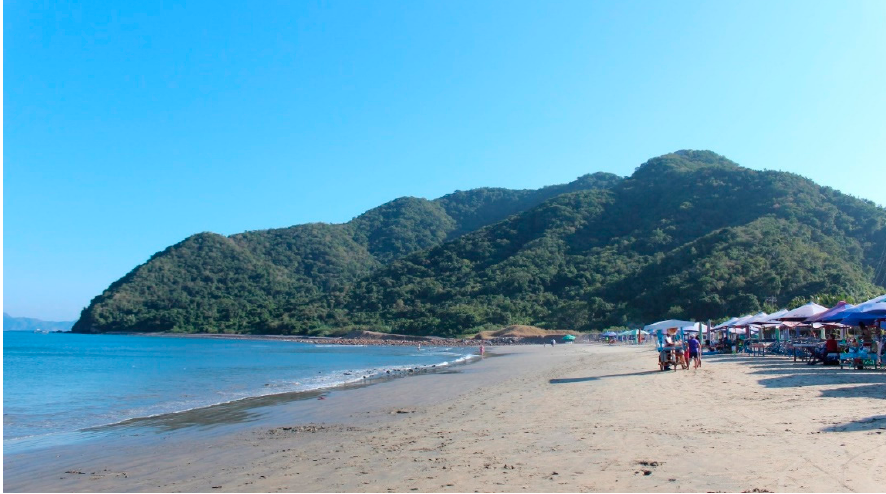
Figure A2. The Juluapan Lagoon shore in holiday season. (Photo Omar Cervantes, Ricardo Guzman).